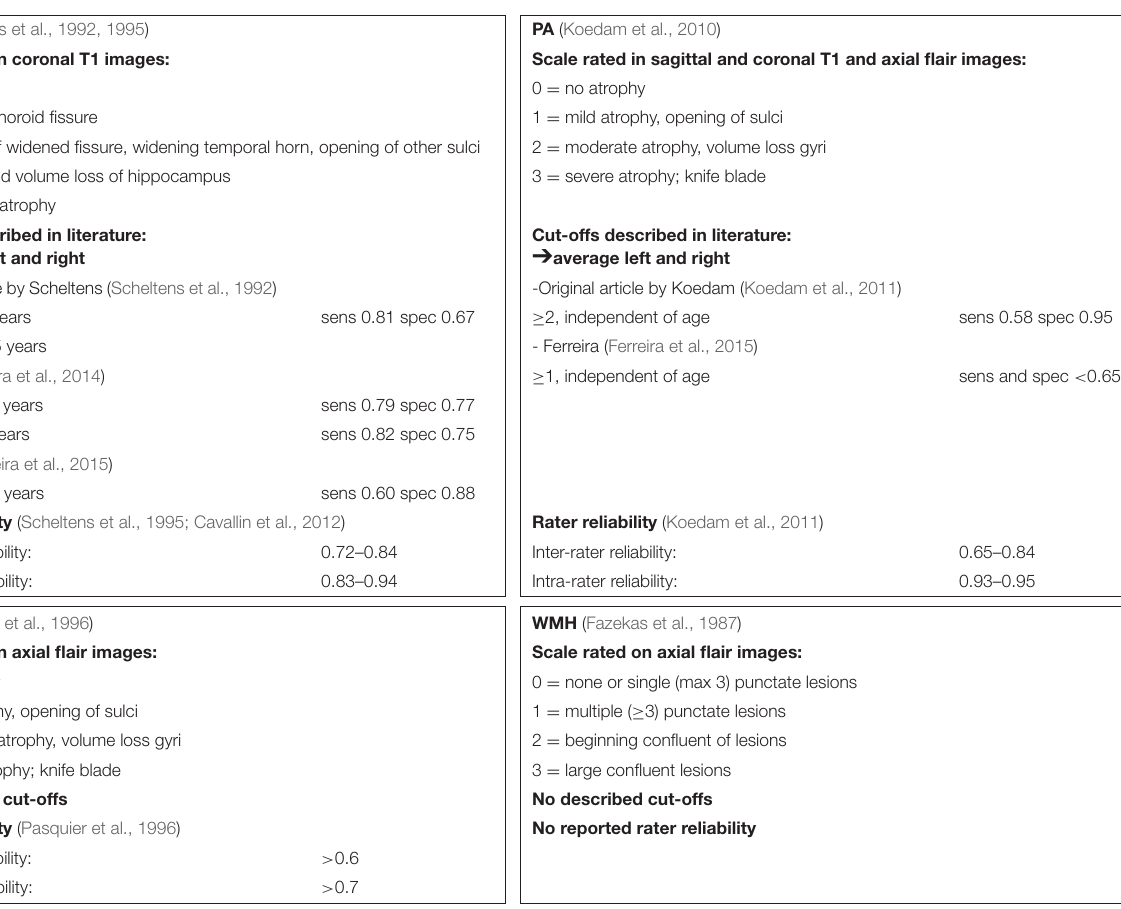
TABLE 1 | Details on used visual ratings scale of MTA, PA, CGA, and